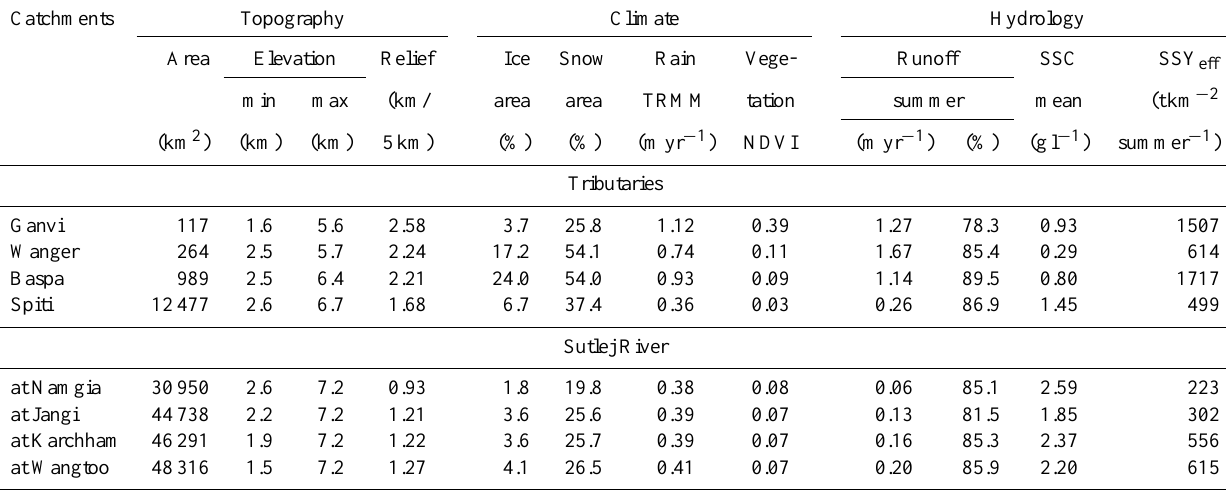
Table 2. Topographic, climatic and hydrological characteristics of the studied watersheds. Locations of the catchments are indicated in Fig. 1. The snow-covered area, the TRMM 3B42 rainfall magnitudes, and the NDVI represent the annual mean of each watershed. Summer indicates the period from May to October. Both the suspended sediment concentration (SSC) and the effective suspended sediment yield (SSY eff ) refer to the summer